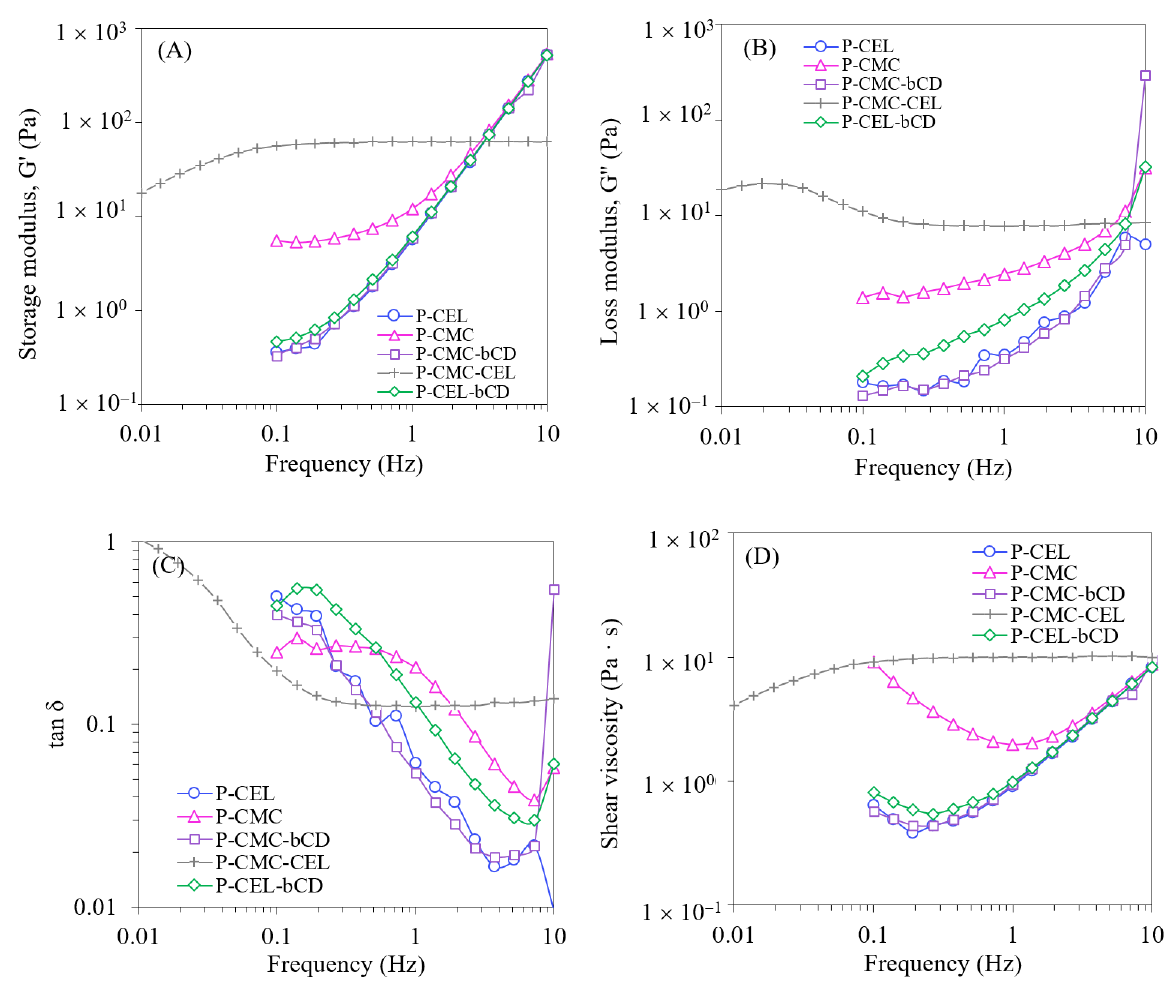
Figure 10. Rheological properties of PEGDE crosslinked cellulose, CMC, βCD -based hydrogel ( A ) Storage modulus, ( B ) Loss modulus, ( C ) tan δ and ( D ) shear viscosity of swelling gels.